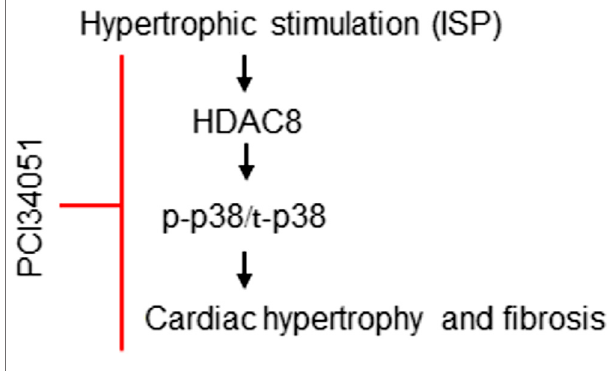
FIGURE 8 | Proposed role of HDAC8 in cardiac hypertrophy and fi brosis. Beta-adrenergic agonist isoproterenol increases the expression of HDAC8. Higher levels of HDAC8 induce p38 MAPK phosphorylation and increase the expression of cardiac hypertrophic markers ANP and BNP. PCI34051, a selective inhibitor of HDAC8, retards cardiac hypertrophy and fi brosis by inhibiting p38 MAPK activity.